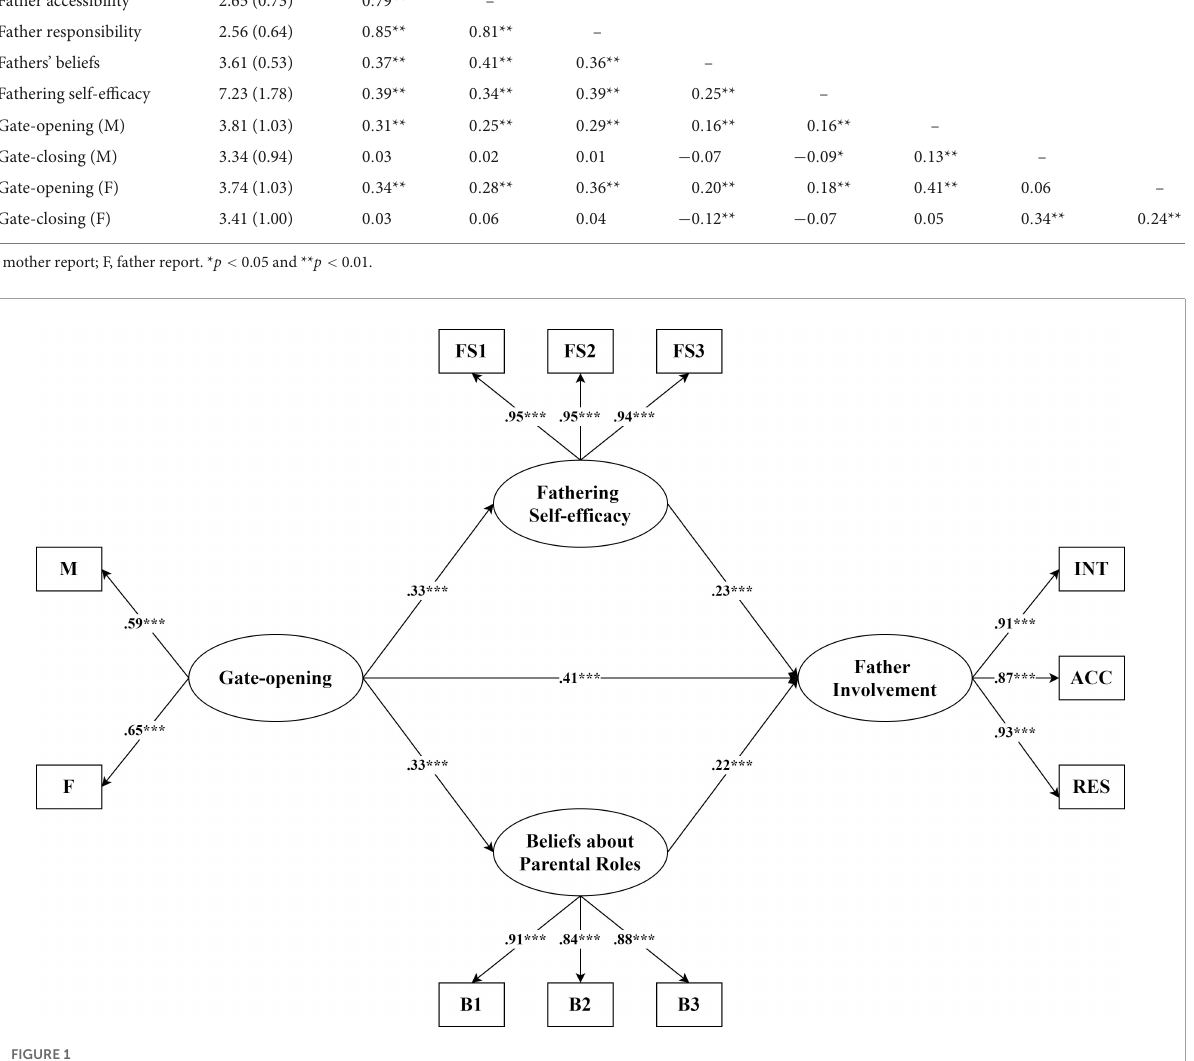
FIGURE1 Structural equation model of relationships among fathering efficacy, fathers’ beliefs, gate-opening, and father involvement. Estimates are presented in standardized units. Model fit: χ 2 (103) = 198.66, p < 0.001; RMSEA = 0.04; 90% CI [0.03, 0.05]; CFI = 0.98; TLI = 0.97; and SRMR = 0.04. *** p <